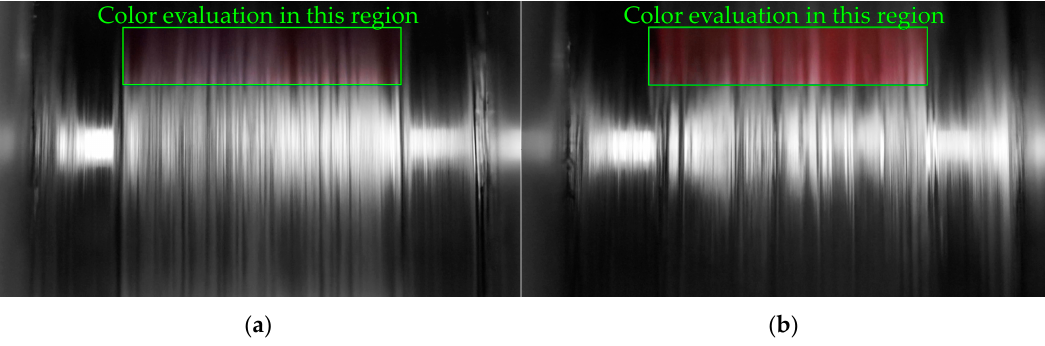
Figure 14 . Typical pictures (frames of the video file) captured during melting experiments of two pure polymers. The rectangular shows the analyzed region. The color outside of the analyzed region is not analyzed and greyed out in these depictions. ( a ) Pure blue PP-H, grade B; ( b ) pure red HDPE.